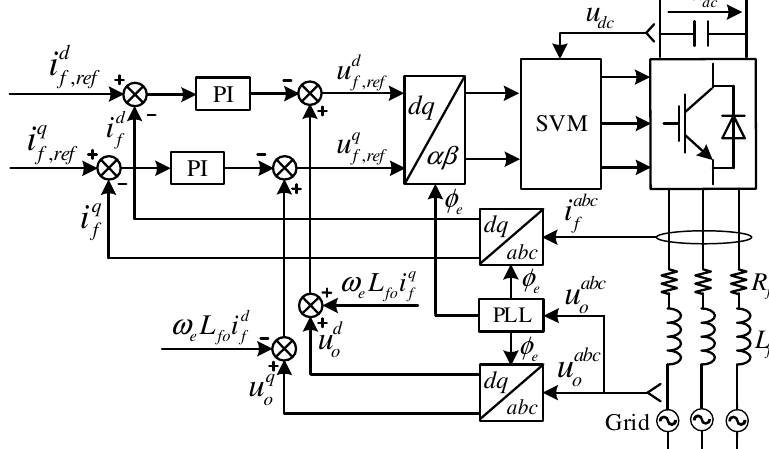
Figure 1. Schematic-diagram of the VOC technique for grid-tied power